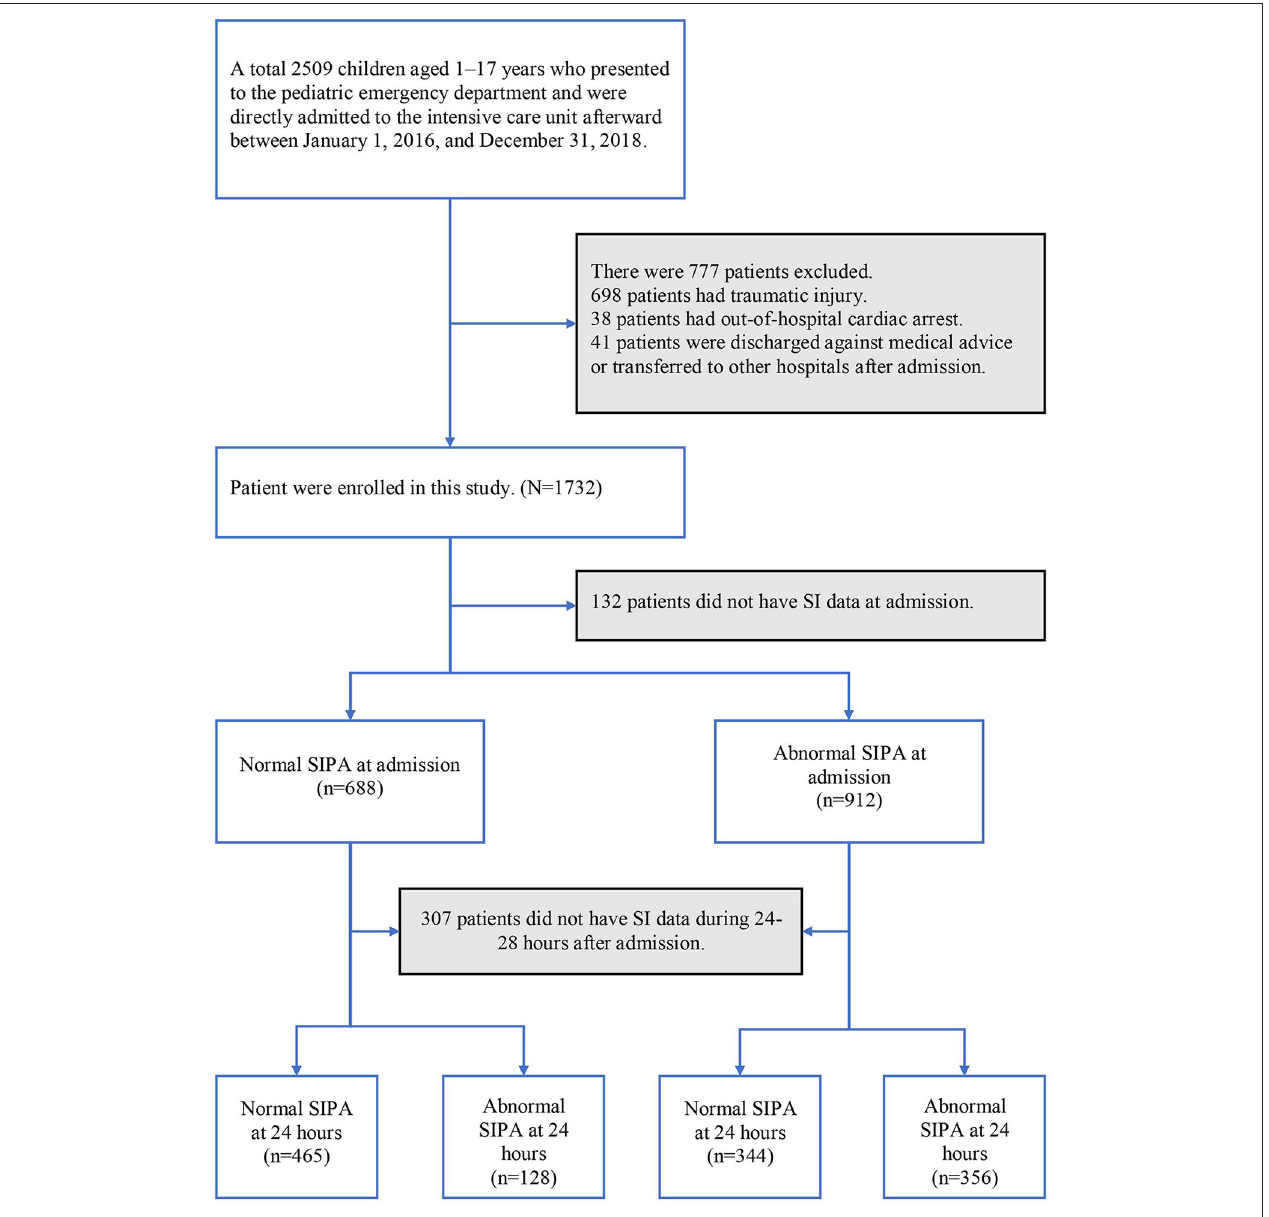
FIGURE 1 | Patient inclusion flowchart. SI, shock index; SIPA, shock index, pediatric